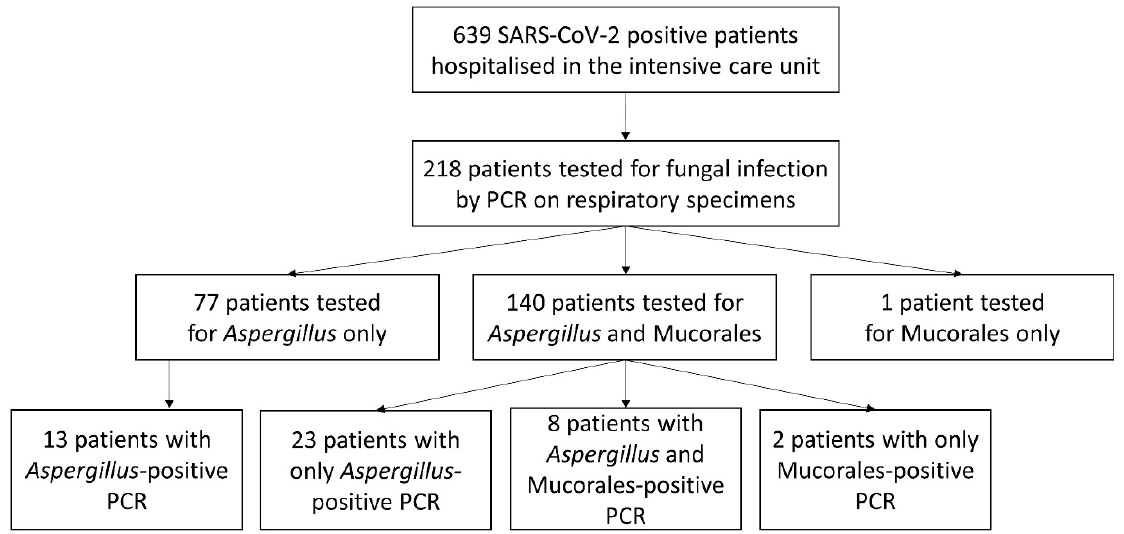
Figure 1. Flow chart of patients.